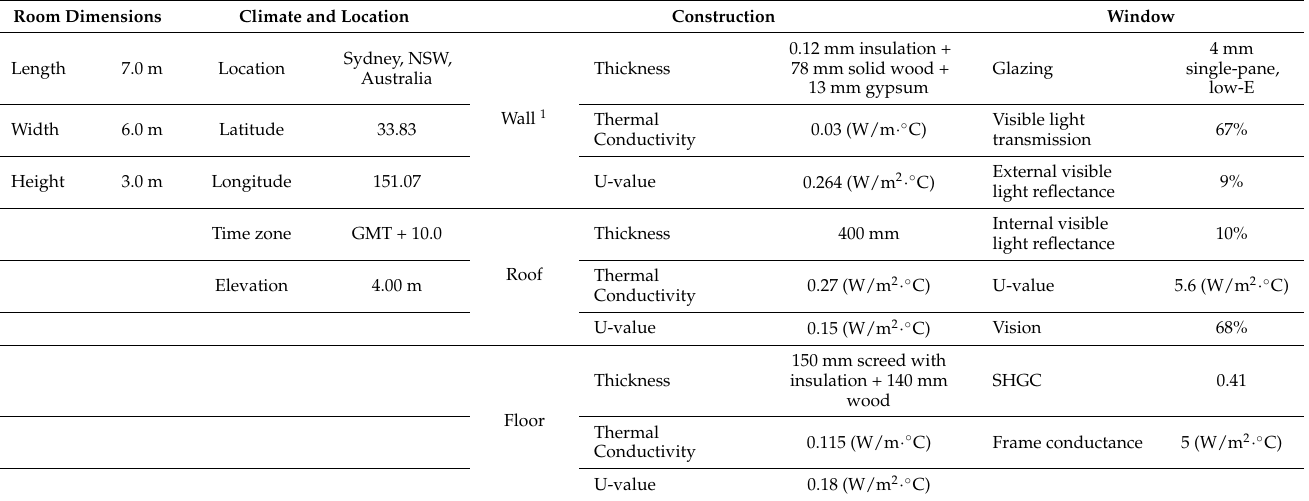
Table 1. Construction, material, thermal, and lighting setting of the room. Material properties data were obtained from ASHRAE HOF 2005, Commonwealth Scientific and Industrial Research Organisation (CSIRO), Australian Fenestration Rating Council (AFRC), and Australian National Construction Code (NCC).